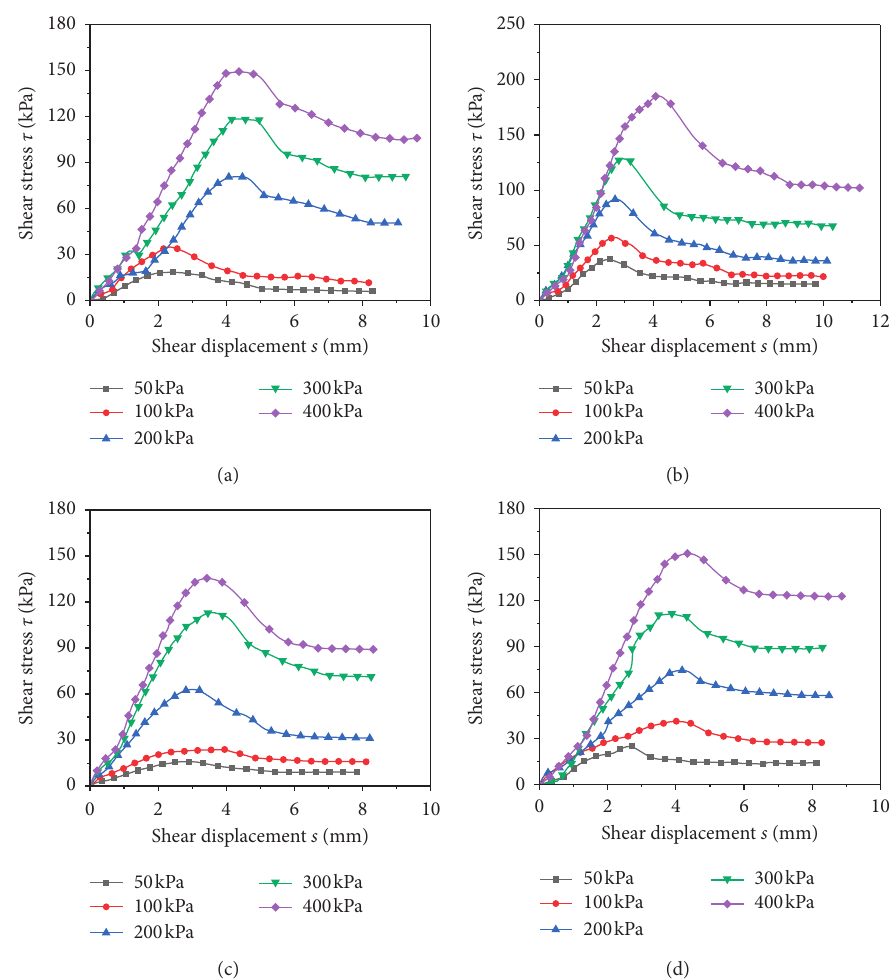
Figure 9: Supplementary shear stress versus shear displacement with different water contents and dry densities. (a) Water content ω � 17.5%, ρ d � 1.68g/cm 3 , (b) water content ω � 16%, ρ d � 1.76g/cm 3 , (c) water content ω � 14%, ρ d � 1.68 g/cm 3 , and (d) water content ω � 10%, ρ d � 1.61g/cm 3 .